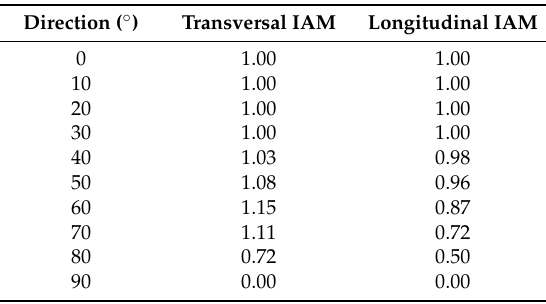
Table 4. Evacuated tube collectors IAM